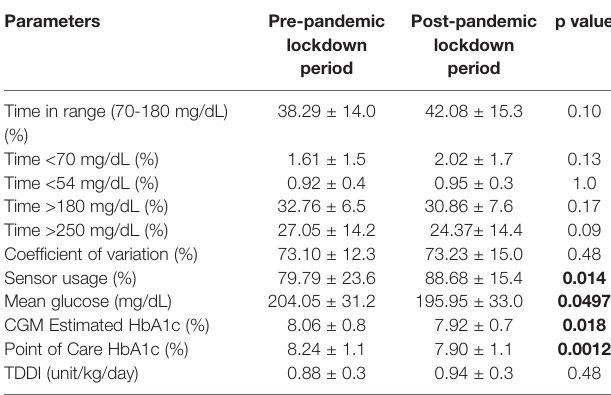
TABLE 3 | Comparison of the differences in CGM metrics between the pre- and post-pandemic lockdown periods among the CGM users only (n=38). Parameters